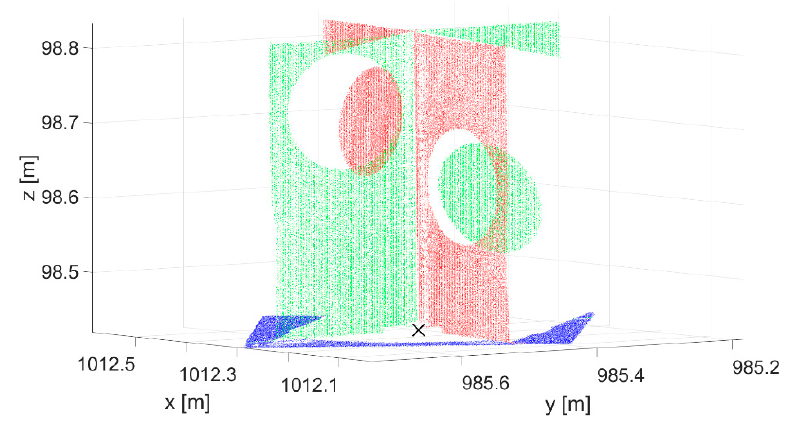
Figure 6. Segmented point cloud of the new target, following secondary segmentation. Reference target point is marked by “×”.